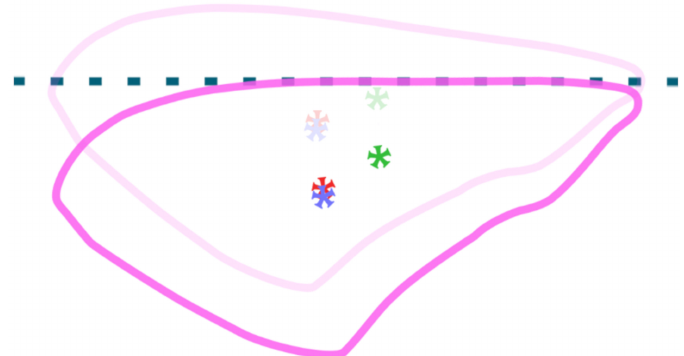
Figure 9. The original orientation (semi-transparent) and new orientation (opaque) of the forewings are shown. Points of interest associated with the forewing are included; center of mass (green), area centroid (red), and center of pressure (blue). In the new orientation, all three points of interest have moved farther from the flip axis (dashed line) to improve passive pronation and supination of the